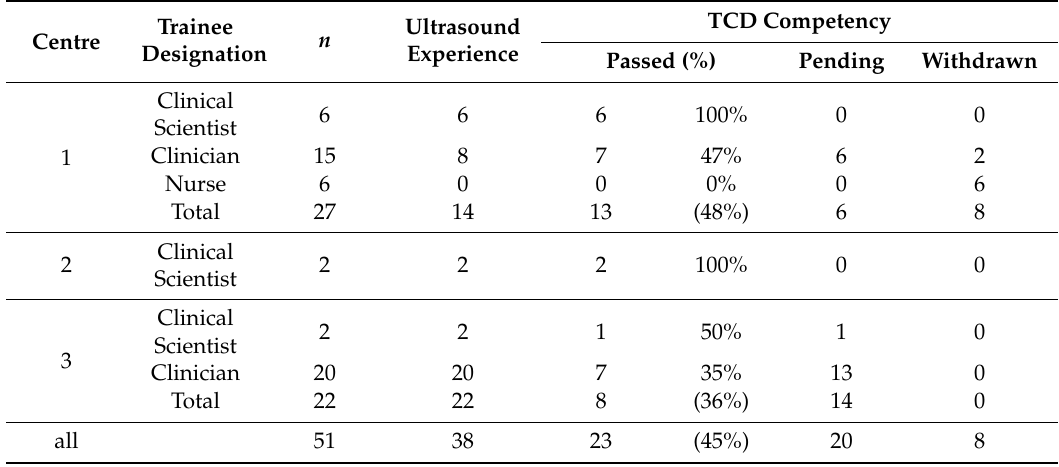
Table 1. Results of Transcranial Doppler Ultrasound (TCD) competency evaluation of the 51 trainees who attended the modular TCD training